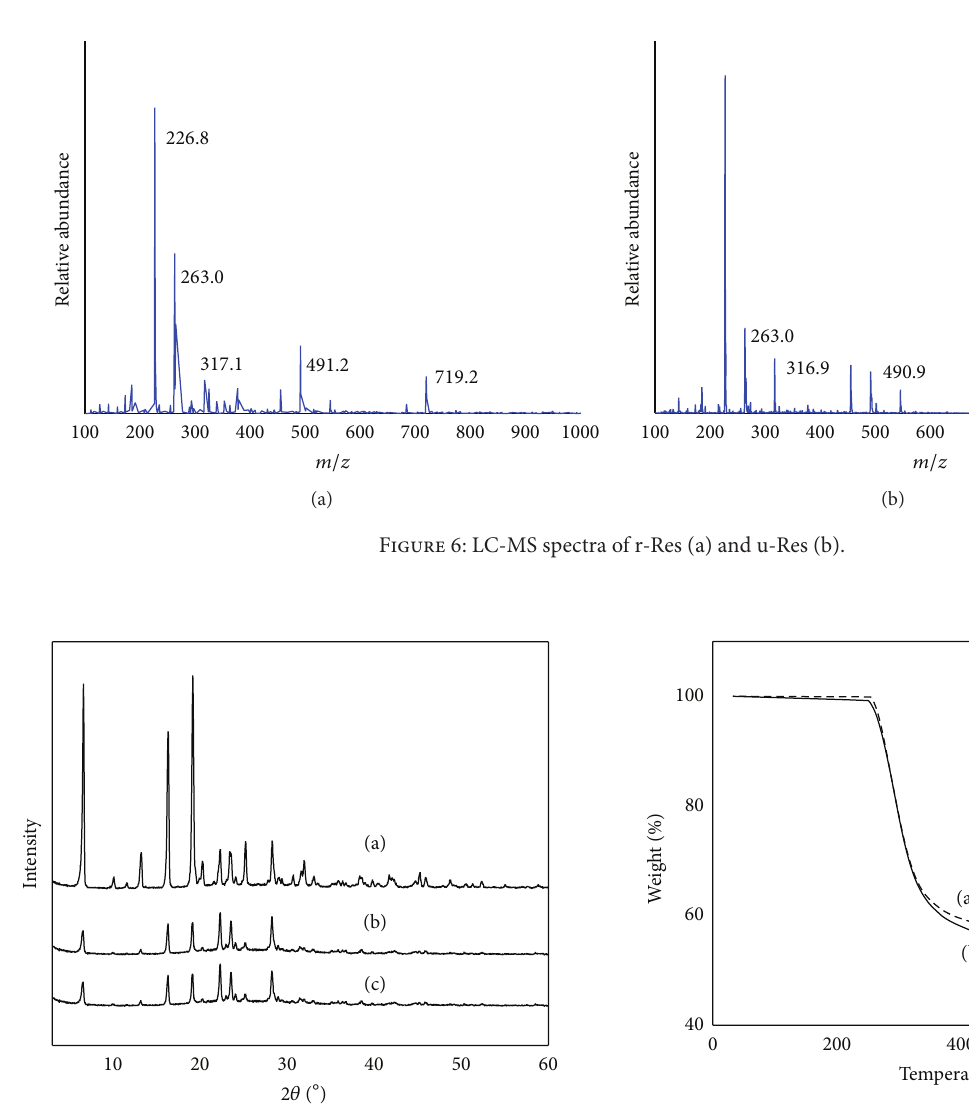
Figure 9: TG curves of r-Res (a) and u-Res